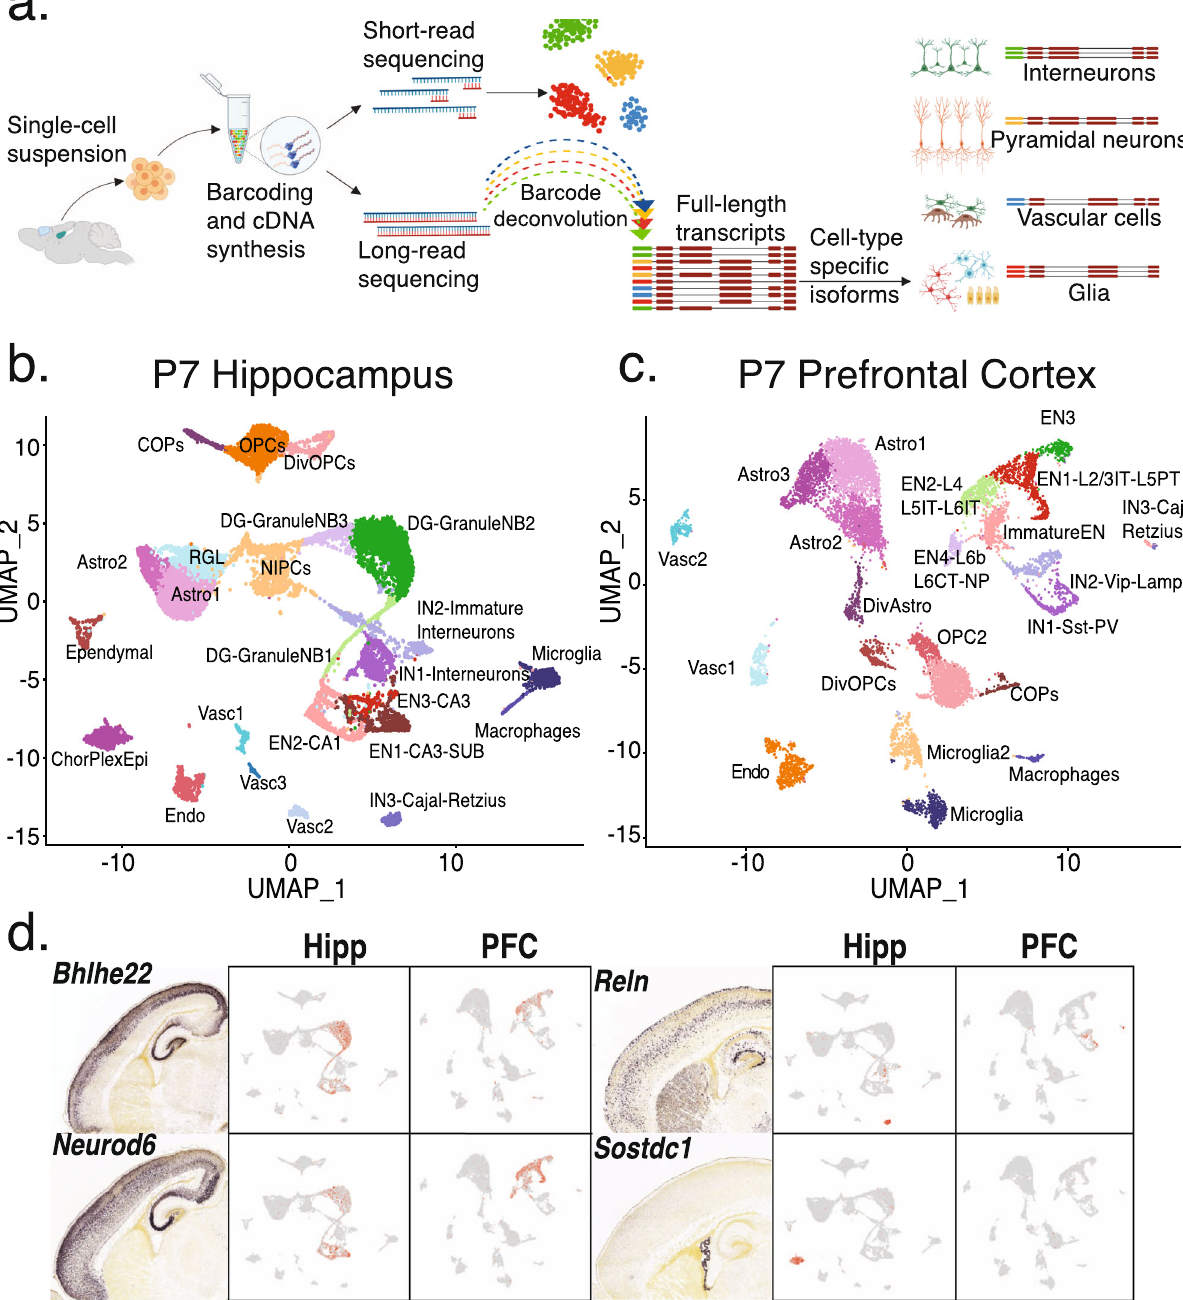
Fig. 1 Short read clustering of P7 hippocampus and prefrontal cortex tissue recovers precursors to known adult cell-types. a Schematic of the ScISOrSeq work fl ow (created with BioRender.com). b UMAP of P7 hippocampus (HIPP) data. Cell-types identi fi ed by marker genes, RNA velocity analysis, and alignment to published data shown in S1. c UMAP of P7 prefrontal cortex (PFC) data. Cell-types identi fi ed by marker genes, RNA velocity analysis, and alignment to published data shown in S2. d In situ hybridization (ISH) images from Allen developing mouse brain atlas for marker genes and corresponding projections on UMAP plots from HIPP and